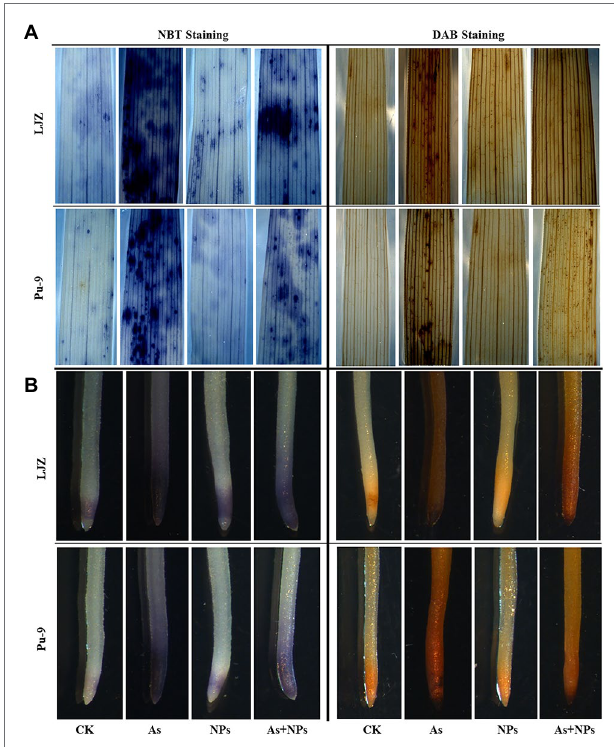
- O • 2 through NBT and H 2 O 2